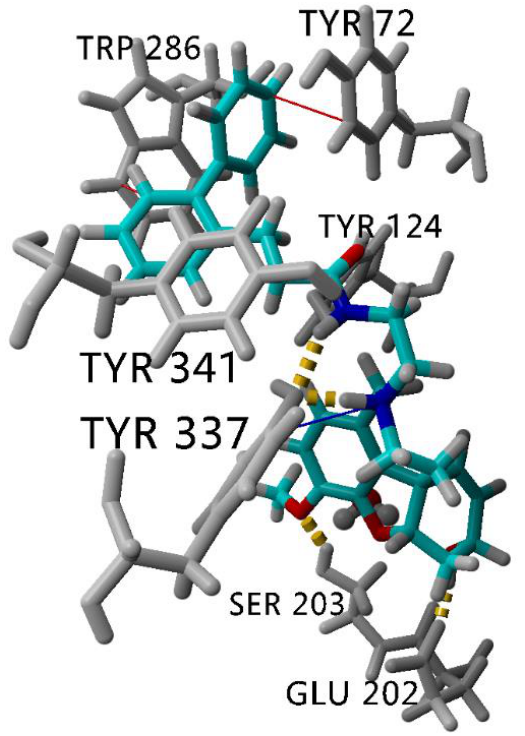
Figure 6. The best-scored docking pose of compound 8 into rh AChE. Hydrogen bonds are shown in yellow dashes, cation-π interaction-in blue line and π-π interaction-in red line. The enzyme residues are given as gray sticks. Compound 8 is colored by element. The structural water molecule within the binding site is presented in ball-and-stick. Interactions are visualized by YASARA v. 17.1.28 (IMBM, Graz, Austria) [36].